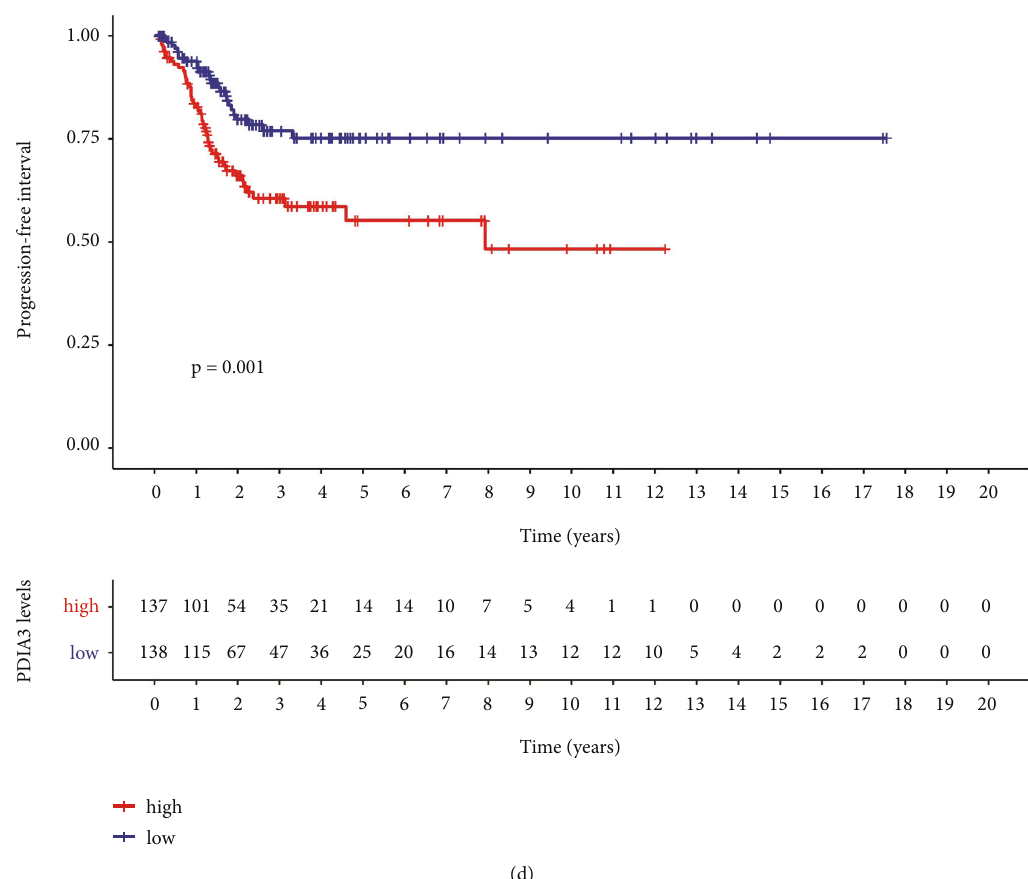
Figure 5: (a) Relationship between PDIA3 expression and overall survival (OS). (b) Relationship between PDIA3 expression and disease- speci fi c survival (DSS). (c) Relationship between PDIA3 expression and disease-free interval (DFI). (d) Relationship between PDIA3 expression and progression-free interval